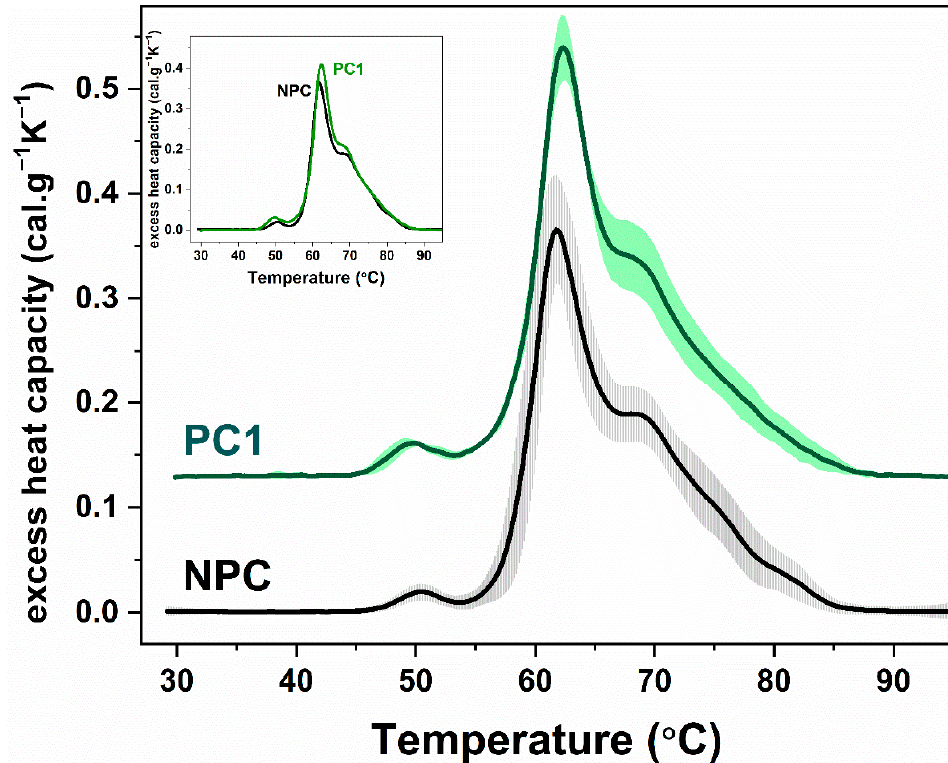
Figure 1. Average DSC profiles and standard deviation of the plasma proteome of control nonpregnant women (NPC, black solid line, gray shadow) and pregnant women registered in the first trimesters of pregnancy (PC1, panel A, dark green solid line, green shadow). For clarity, the thermograms are displaced vertically. Inset represents the overlapping average denaturation profiles of NPC and PC1 groups. All thermograms are recorded with a scan rate of 1 °C min − 1 in the range of 30–95 °C. Table 2. Thermodynamic parameters (temperatures of denaturation, Tm, and excess heat capacities of the successive thermal transitions, c P ; the c P ratio of albumin and immunoglobulins assigned transitions, c PHSA /c PIgs ; calorimetric enthalpy, ∆ H, and weighted average center of the thermogram, T FM ), estimated from the DSC profiles of blood plasma for non-pregnant (NPC) and pregnant women in the first trimester of pregnancy